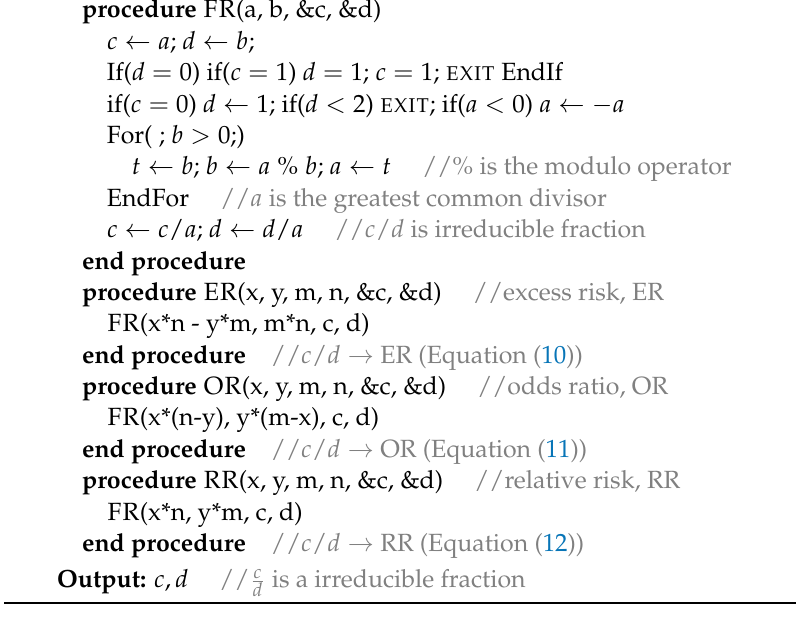
Algorithm 3: Bivariate binomial experiment, Equation